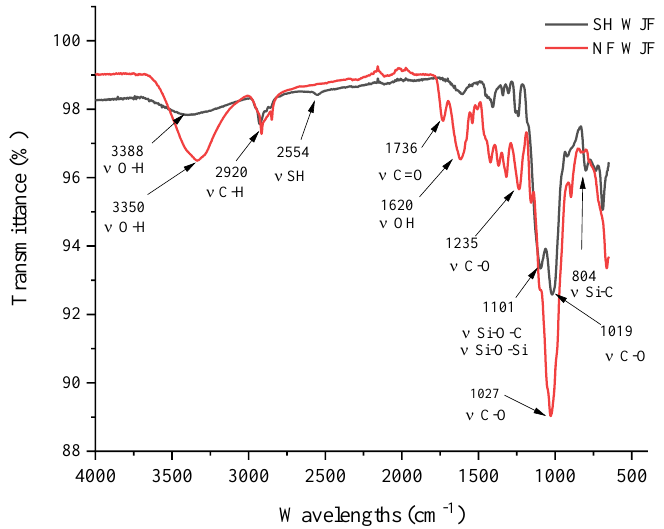
Figure 1. Comparison of the FTIR spectra of: NF WJF (red) and SH WJF (black). stands for stretching band.